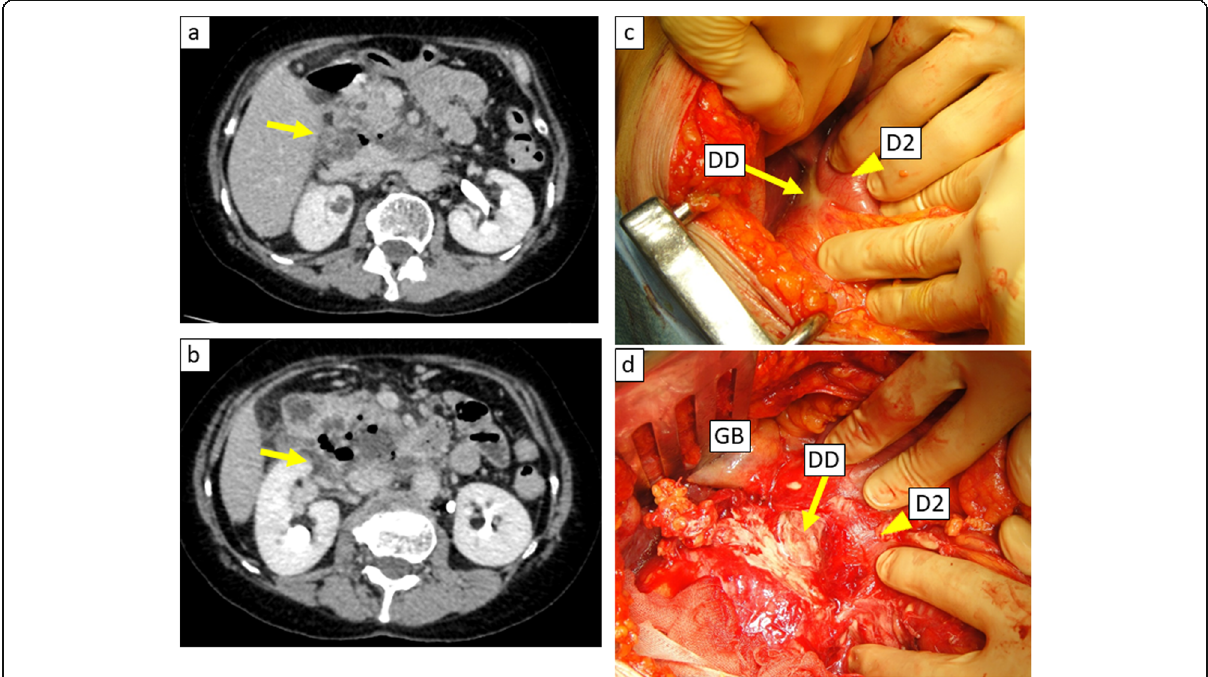
Fig. 1 a , b Computed tomography images showing abscess with free air surrounding the second portion of the duodenum (yellow arrow). c , d Surgical findings of the perforation site. The perforated duodenal diverticulum (DD, yellow arrow) was identified on the dorsal side of the second portion of the duodenum (D2, yellow arrowhead; GB,